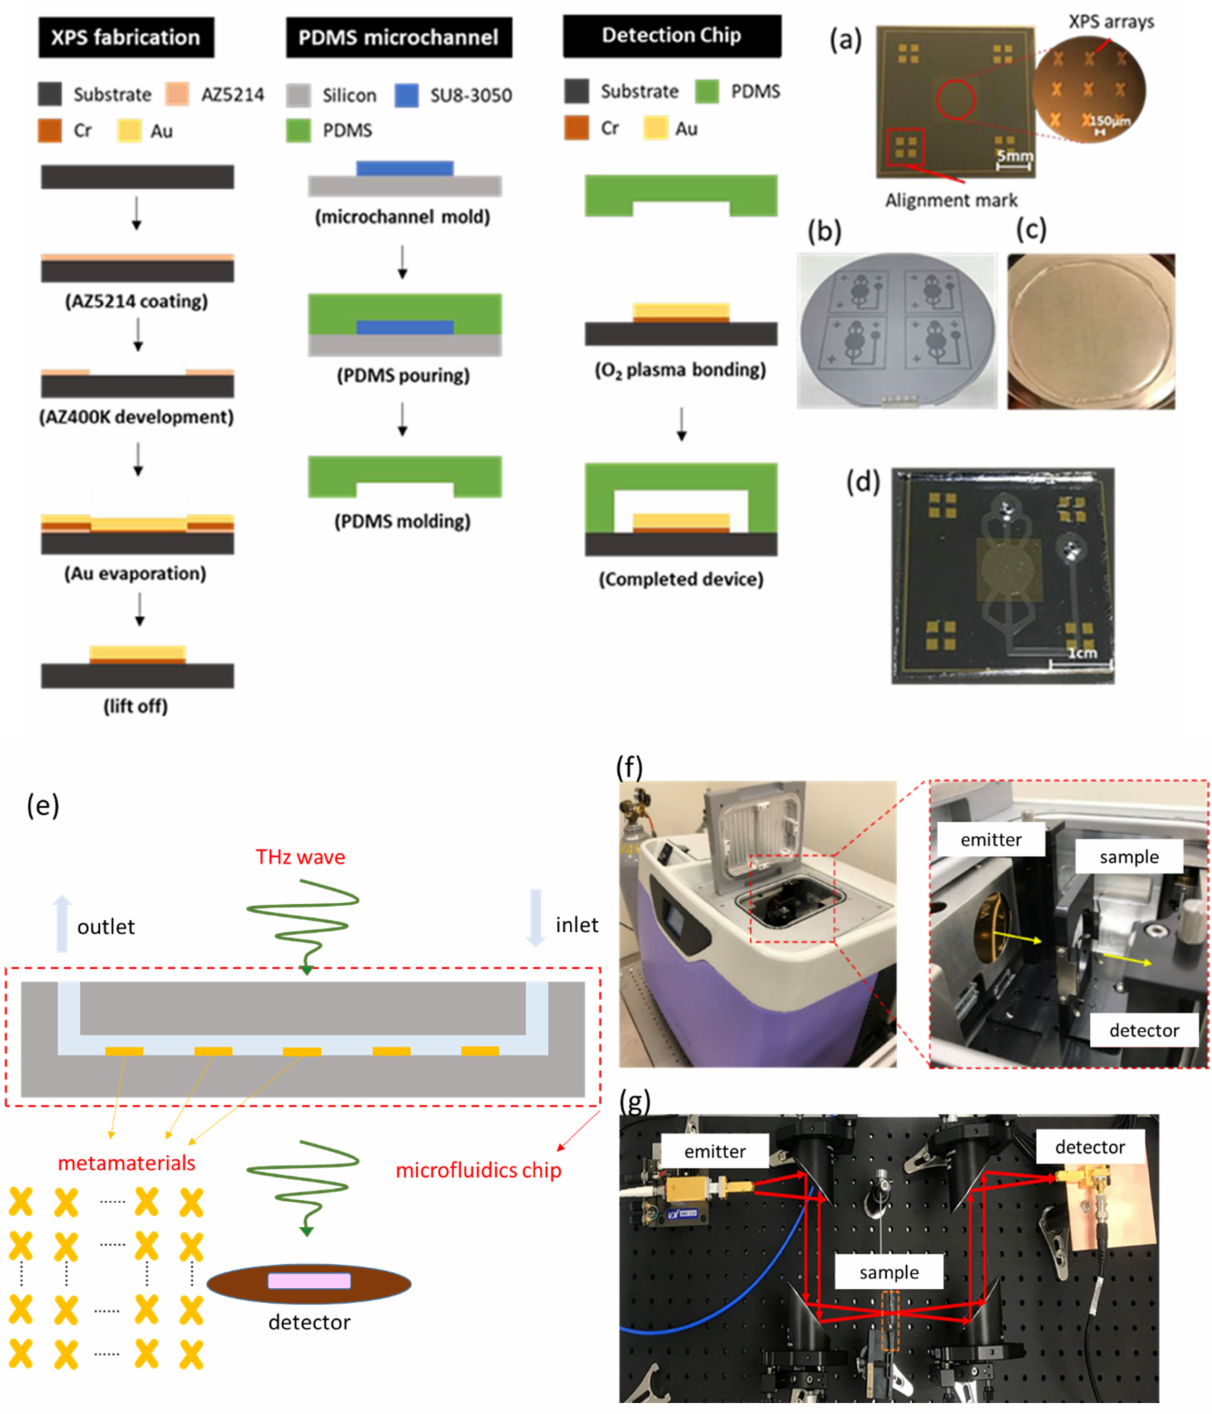
Figure 2. Fabrication process flow and ( a ) metamaterial; ( b ) SU8 mold; ( c ) PDMS microfluidic layer; ( d ) finished product (detection chip). ( e ) Schematic diagram of experimental setup; ( f ) TeraPulse System structure diagram; ( g ) VDI System structure